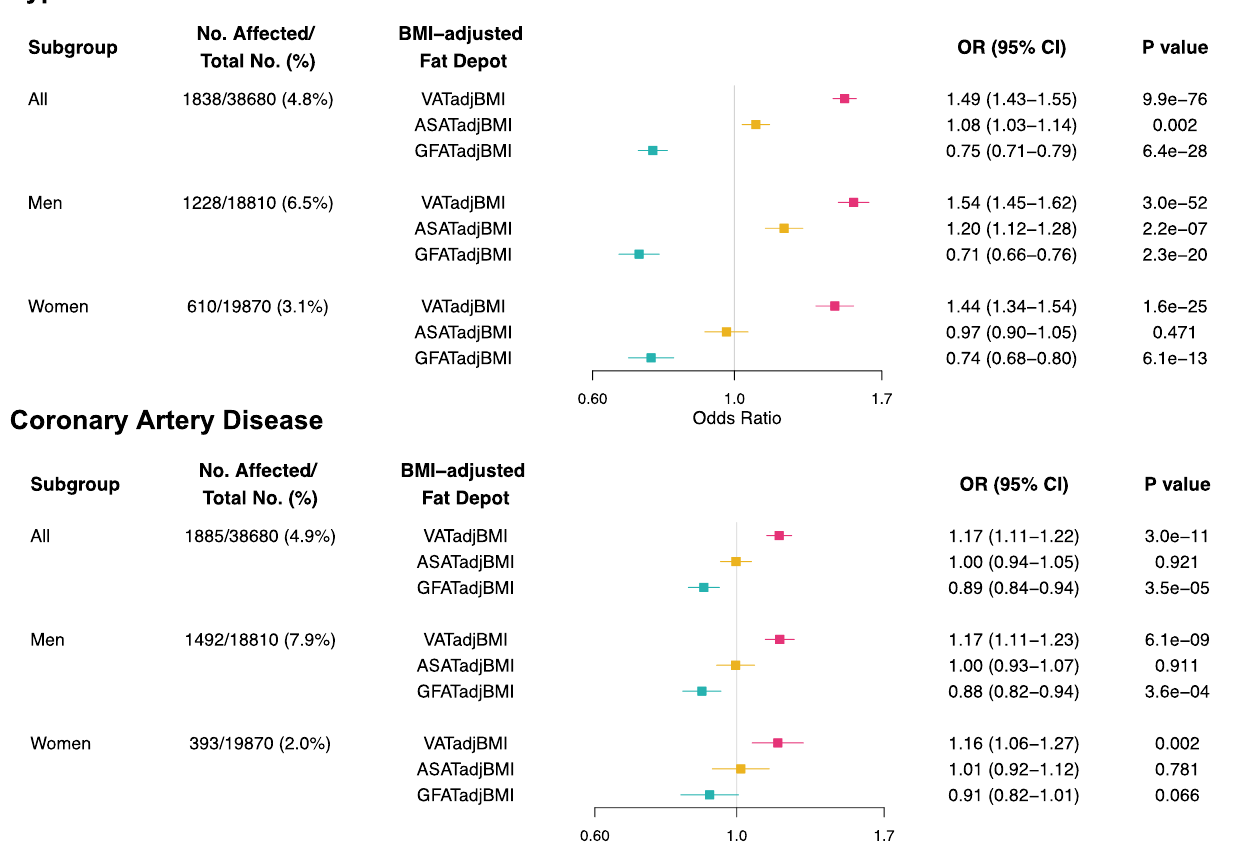
Fig.3|Associationofbody-massindexadjustedfatdepotswithtype2diabetes and coronary artery disease. Odds ratios per standard deviation with 95% con- fi dence intervals are shown for prevalent type 2 diabetes and coronary artery dis- ease. Sample sizes for each model are shown as the denominator in the second column. P-values correspond to two-sided tests for the indicated independent variable in an adjusted logistic regression. Logistic regression models were